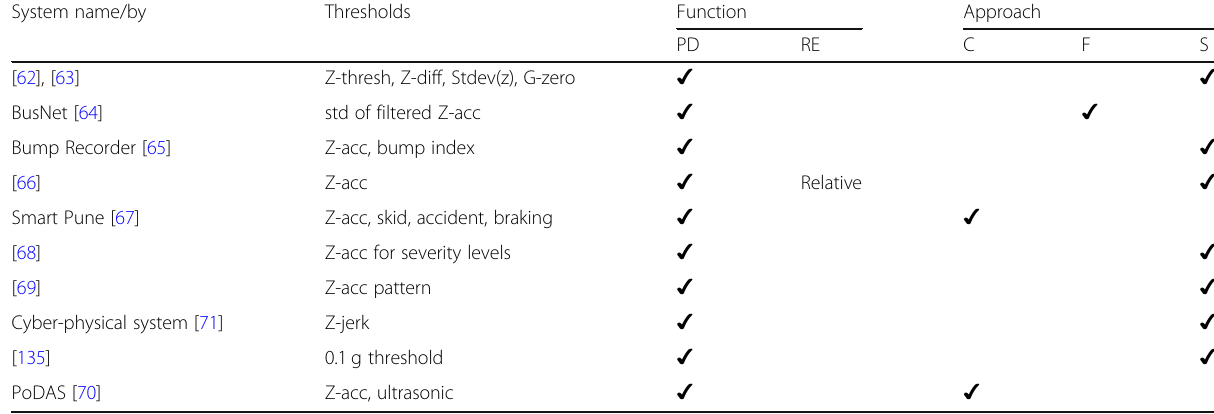
Table 4 Summary of threshold-based methods for pothole detection and roughness index estimation System name/by